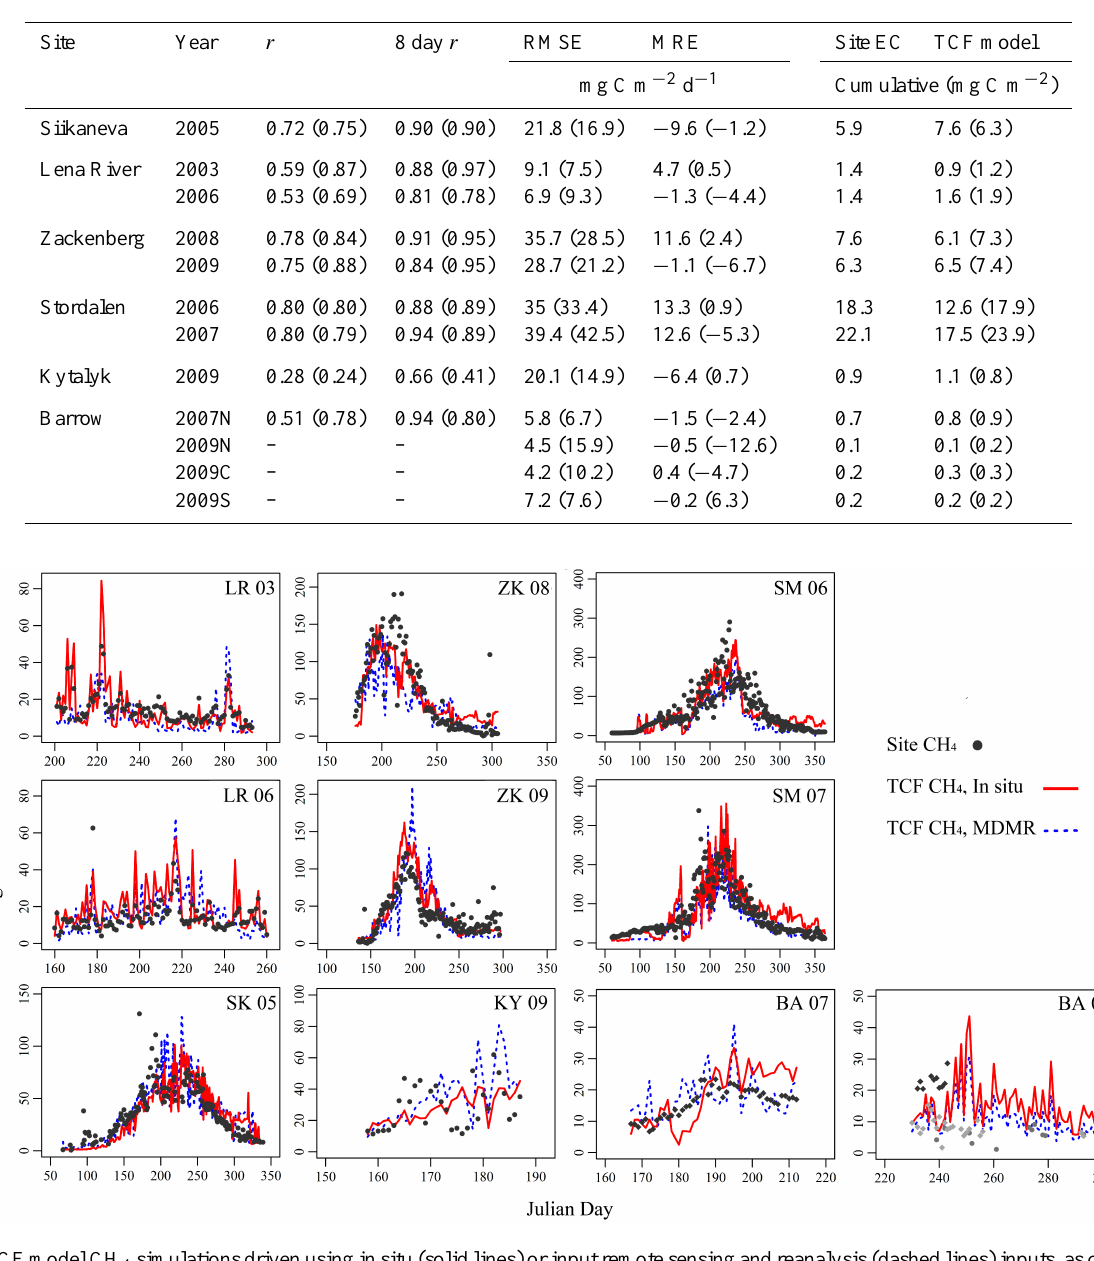
Table 3. Tower EC CH 4 records and TCF model results using in situ information (in parentheses) or satellite remote sensing and reanalysis inputs. The Pearson correlation coefficients ( r ) are significant at a 0.05 probability level, excluding Kytalyk 2009 ( r ≤ 0.28, p ≥ 0.07).